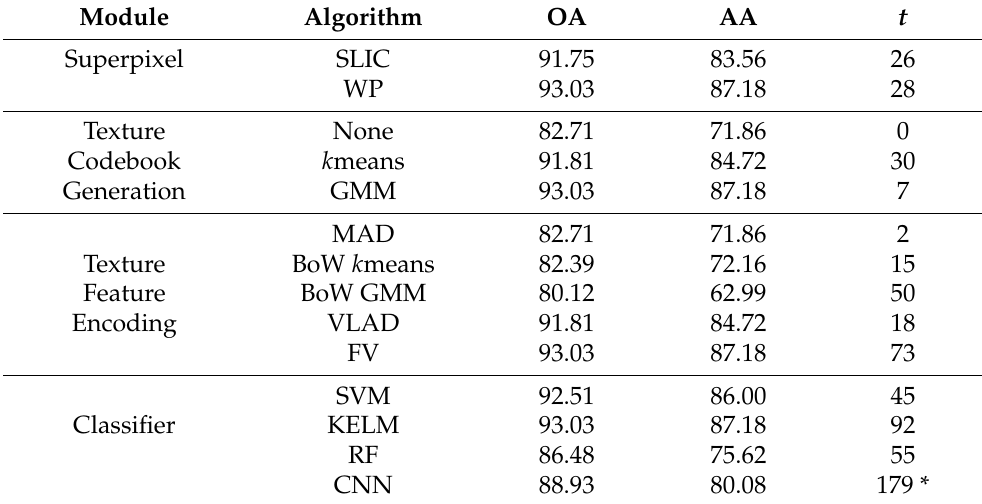
Table 2. Classification accuracies and execution times obtained by the different algorithm alternatives for each module. The Oitaven dataset and 15% training superpixels were used in the experiments. Execution times are indicated in seconds (the time with an asterisk indicates that the corresponding algorithm was run on a